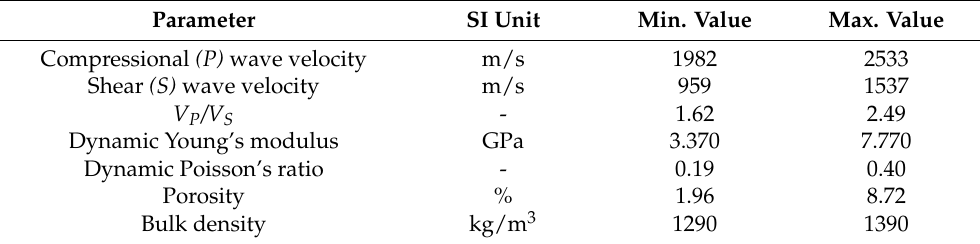
Table 9. Variability thresholds of the mechanical parameters of coal: dynamic testing. Parameter SI Unit Min. Value